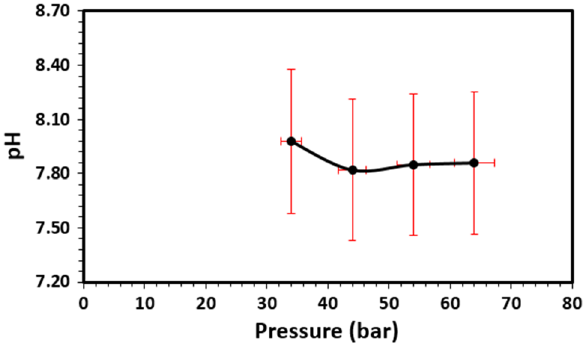
Fig. 14 Effect of different applied pressures on the pH value of the Red Sea water in membrane #4 (AFC99)